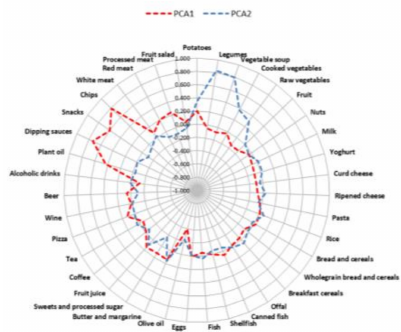
Figure 3. Radar graph of factor loadings that characterize each dietary pattern. The red line represents the distribution of the factor loadings related to the PCA1 component (Western dietary pattern). The blue line represents the distribution of factor loadings related to the PCA2 component (prudent dietary pattern).